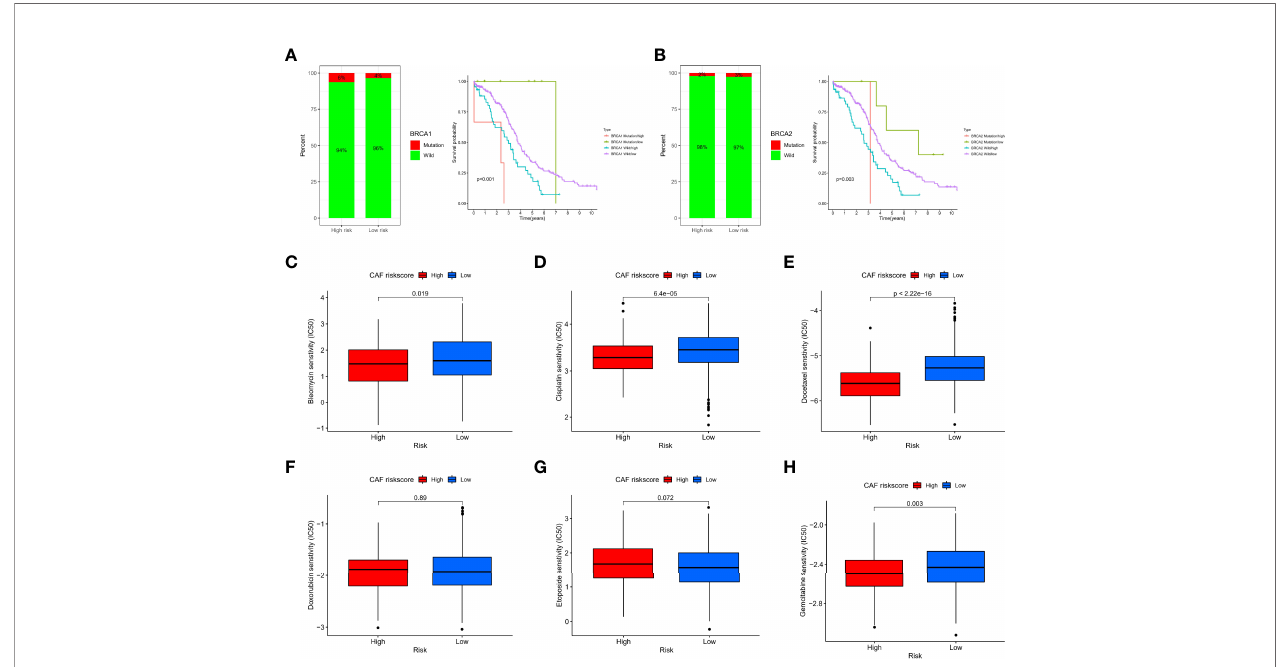
FIGURE 9 | Sensitivity of chemotherapy between different risk groups. (A) Histogram of BRCA1 state distribution and Kaplan – Meier analysis of integrated groupings. (B) Histogram of BRCA2 state distribution and Kaplan – Meier analysis of integrated groupings. IC50 values between different risk groups, including bleomycin (C) , cisplatin (D) , docetaxel (E) , doxorubicin (F) , etoposide (G) , and gemcitabine (H) .